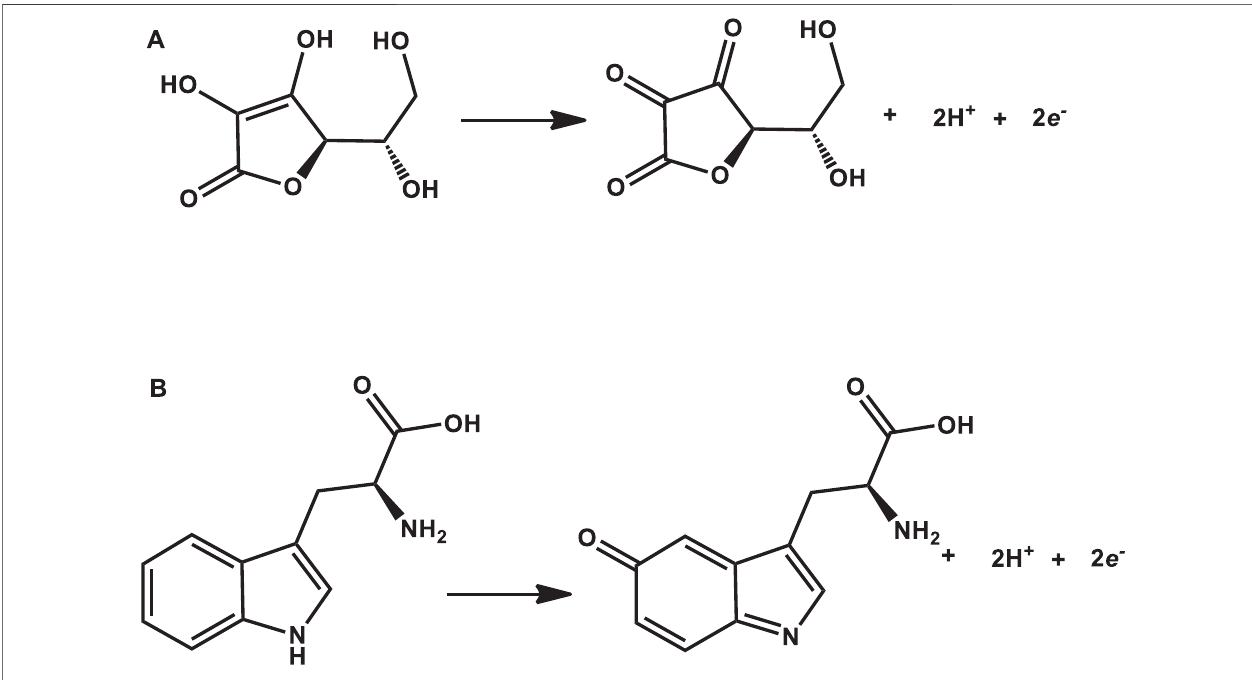
SCHEME 2 | Mechanism of detection of ascorbic acid (A) and tryptophan (B) on poly-CoTCPc-CoTAPc-GONS/GCE, respectively.